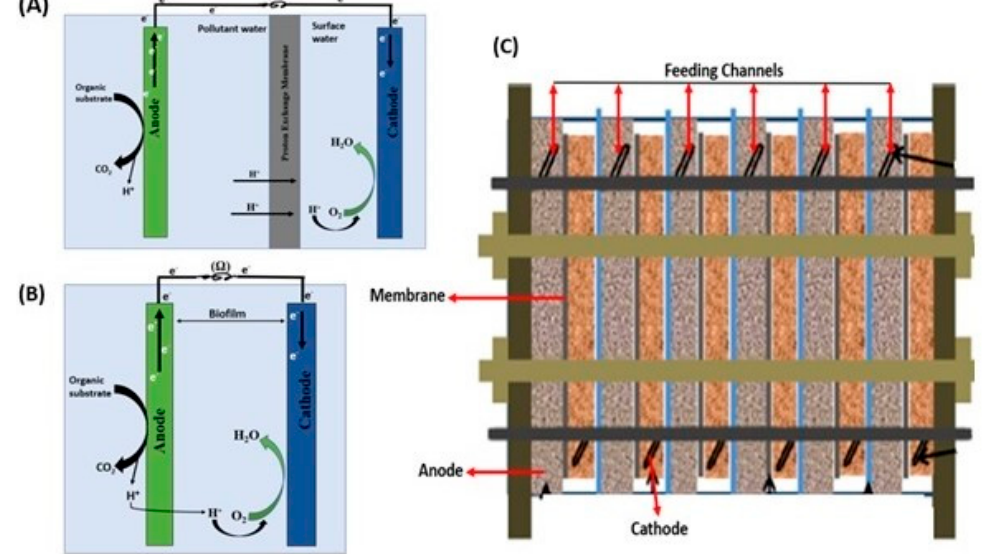
Figure 1. Basic configuration of microbial fuel cells (MFCs). ( A ) Double-chamber MFC (DFMC), ( B ) single-chamber MFC (SFMC), ( C ) stacked MFC.